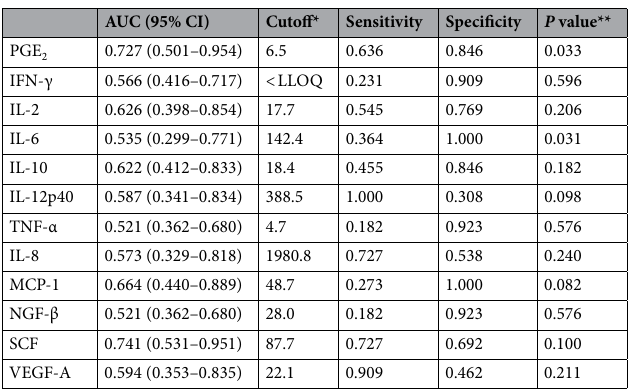
Table 1. ROC analysis of each serum factor in relation to longer survival. The sensitivity and specificity of each factor to predict longer survival (OS > median) are shown. AUC, area under the curve; CI, confidence interval; LLOQ, lower limit of quantification. *Cutoffs were determined by calculating the Youden’s index. **Fisher’s exact test.